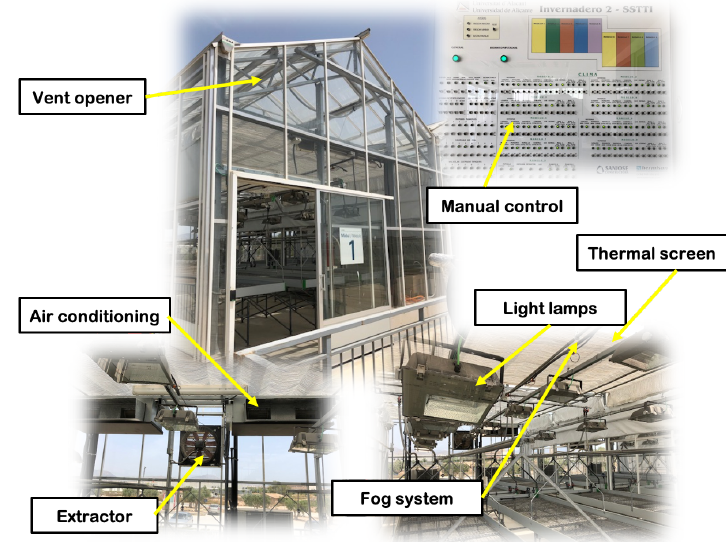
Figure 3. Greenhouse on which the integration model is designed and installed. The current automatic control is integrated with a new intelligent control system that increases functionality and adds new